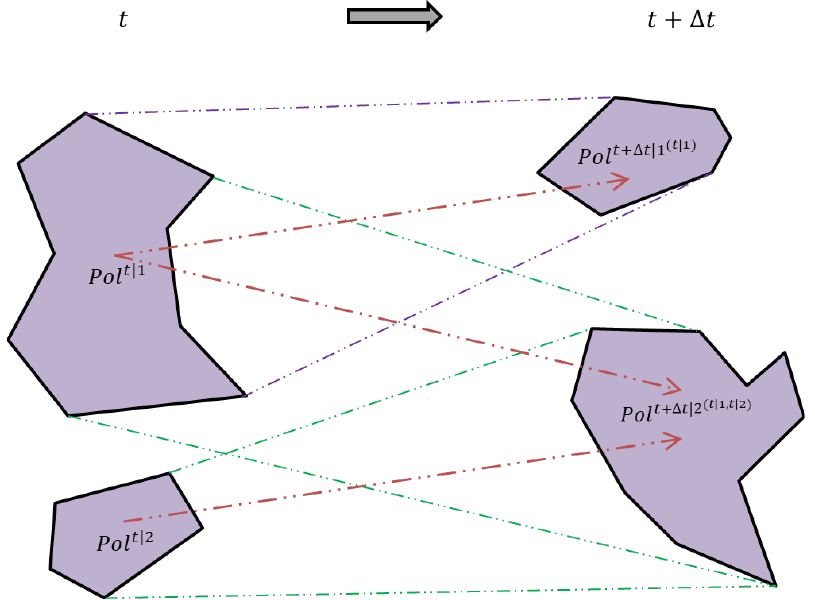
Figure 7. Assignment of polygons for interpolation in the case of simultaneous splitting and merging.